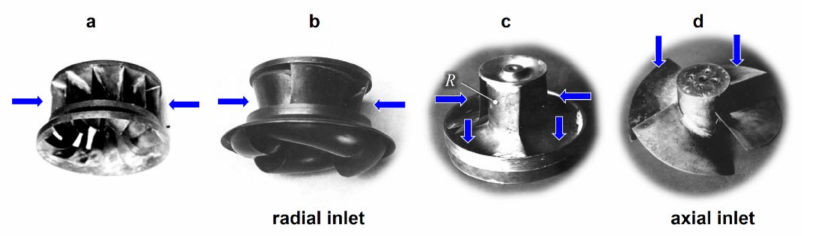
Figure 3. Development of impellers used during the experiments. ( a ) variant a; ( b ) variant b; ( c ) variant c; ( d ) variant d. Source: